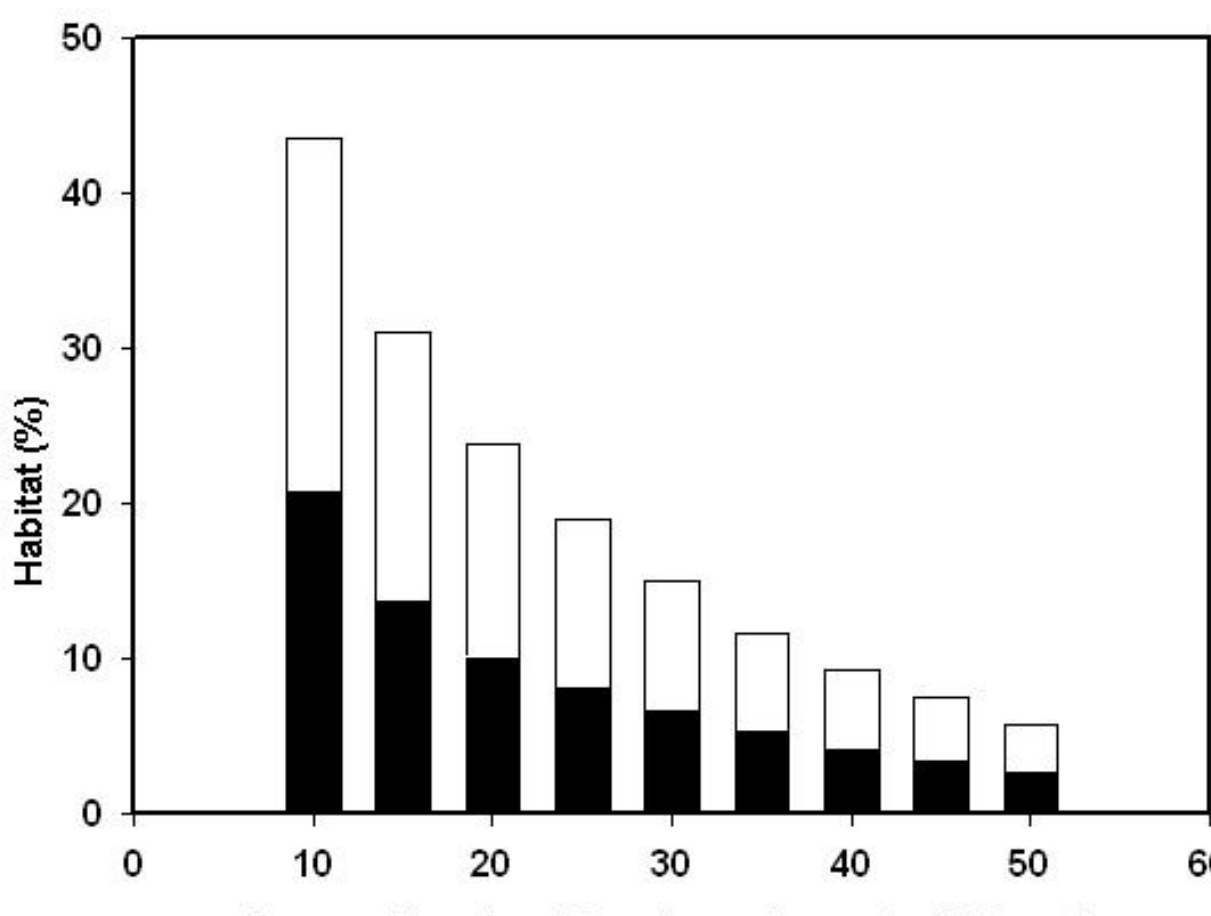
Fig. 2 . Proportion of area covered by wild boar habitat in the study areas of Denmark in relation to minimum forest requirements in home ranges. Black sticks represent the proportion of area with estimated boar density >